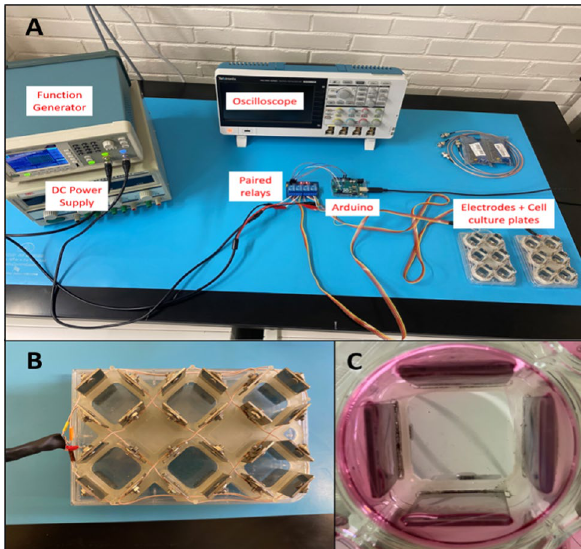
Fig. 2 Circuit schematic of experimental setup. Each elec- trode can be independently disconnected from voltage and ground to isolate the function generator channels and ensure a uniform electric field parallel to the active electrodes. Electrodes in each well are wired in series so that all wells are active simultane- ously